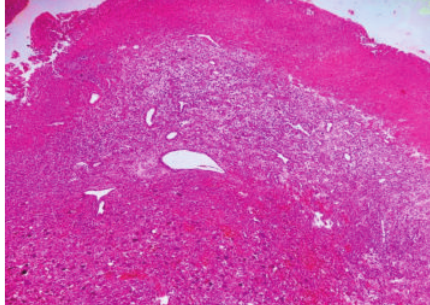
Figure 5: H&E 40x view showing anastomosing vascular channels lined by atypical endothelial cells.